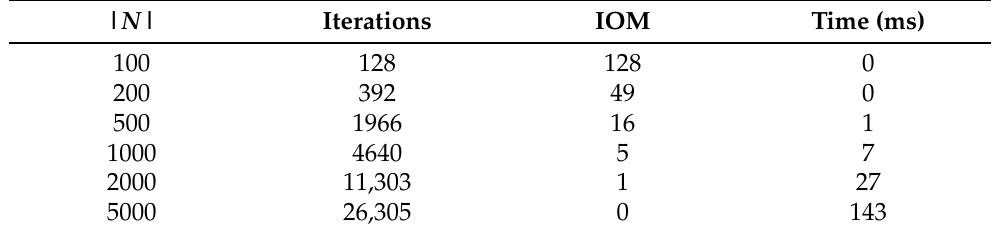
Table 6. Average and theoretical IPa (worst case) iterations, and CPU time.